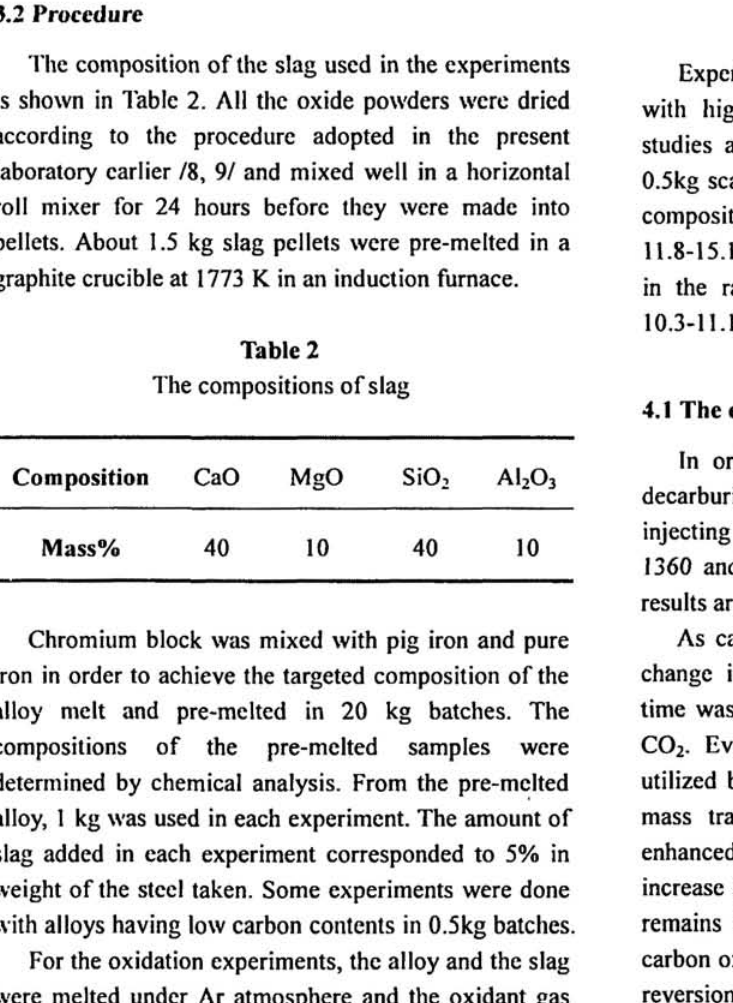
Fig. 1: Λ schematic plot of the induction furnace